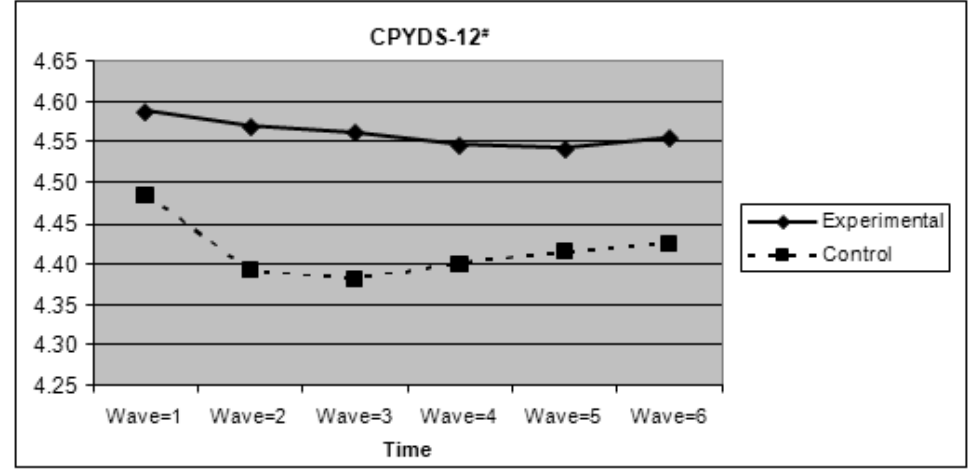
FIGURE 6. Growth trajectories of the experimental participants Δ and control participants using CPYDS-12 # as an outcome indicator. Δ Experimental participants who regarded the program as beneficial. # 12 Subscales of the Chinese Positive Youth Development